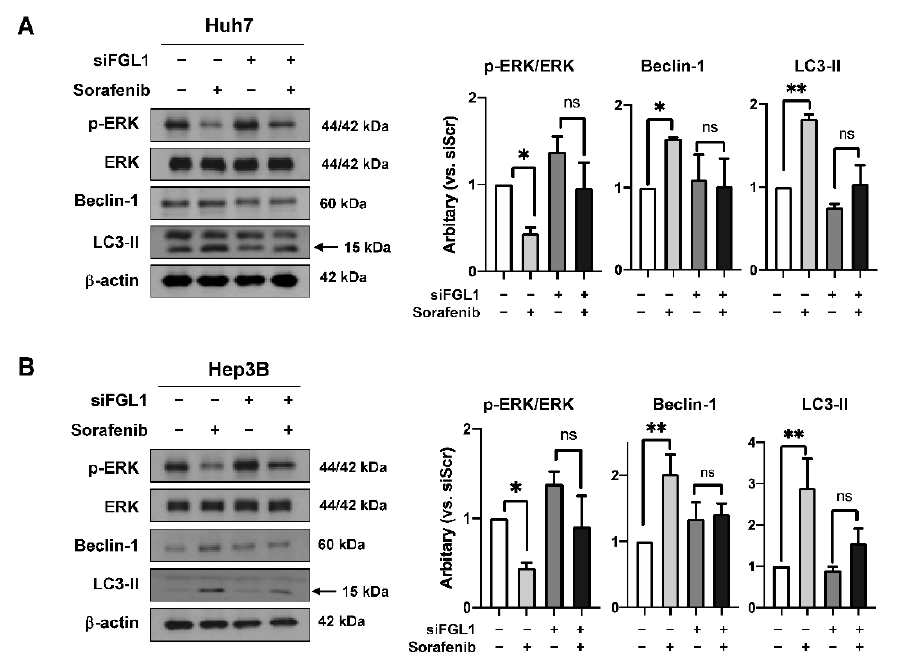
Figure 6. Effect of FGL1 knockdown on p-ERK, ERK, Beclin-1, and LC3-II in hepatocellular carcinoma (HCC) cells following sorafenib treatment. Representative western blot and data from Huh7 ( A ) and Hep3B ( B ) cells. Data are presented as the mean ± standard deviation (n = 3). * p < 0.05 and ** p < 0.01, compared to siScr-treated cells. siFGL1 ( − ), treated with siScr. Sorafenib ( − ), treated with vehicle (DMSO).